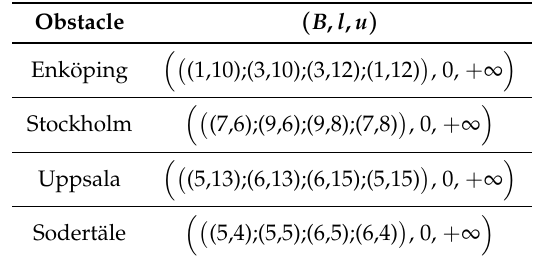
Table 1. The obstacles for test 1.